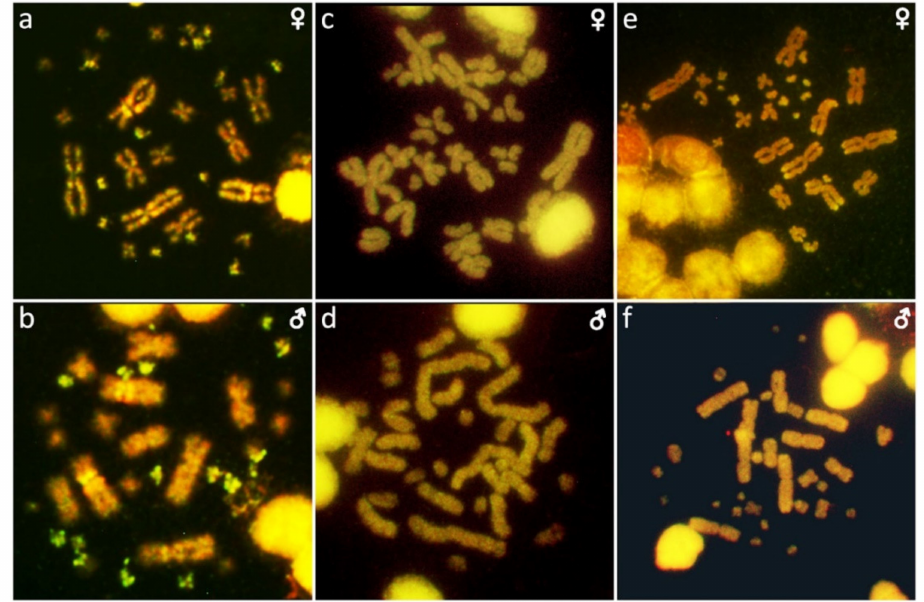
Figure 5. Comparative genome hybridization in Eutropis multifasciata ( a , b ), Scincopus fasciatus ( c , d ), and Tiliqua gigas ( e , f